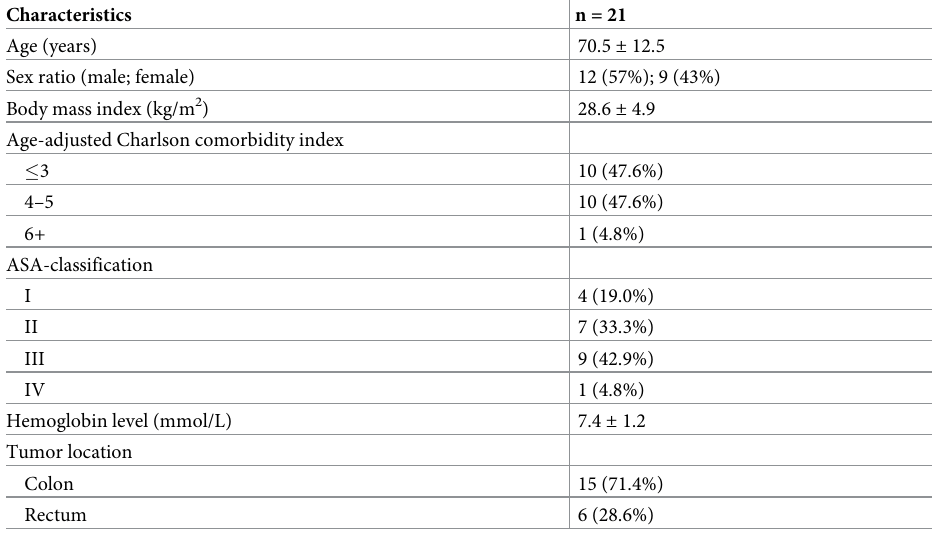
Table 1. Baseline characteristics of